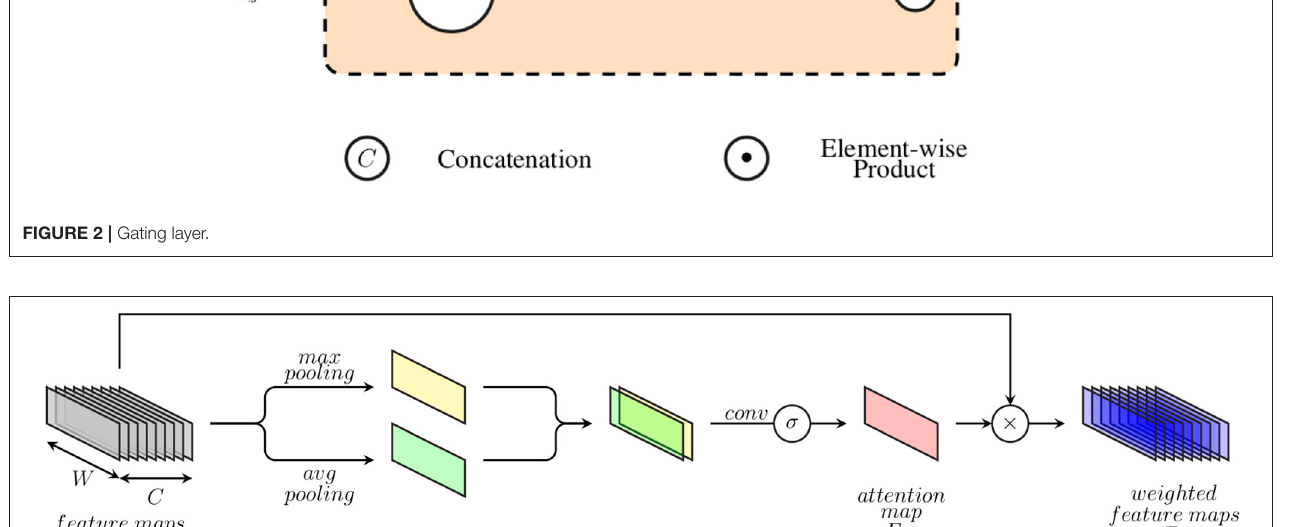
FIGURE 3 | Attention